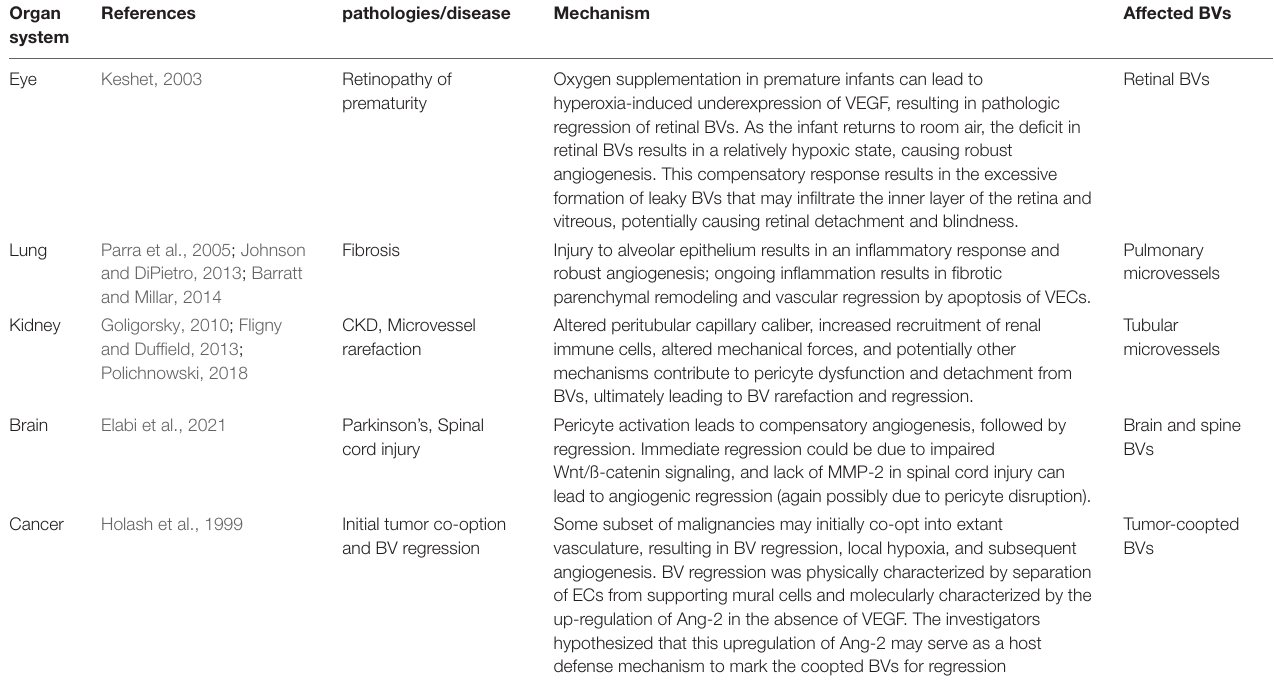
TABLE 1 | Pathologic blood vessel (BV)